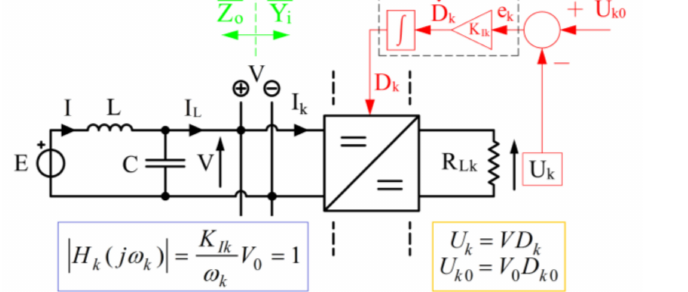
Figure 3. Controlled DC-DC converter supplied by a filtered DC